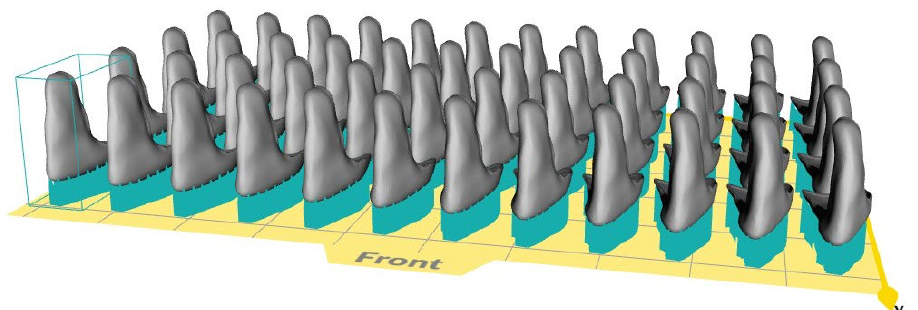
Figure 6. Diastema non-prep veneers on a support structure placed on the virtual build platform of a CeraFab System S65 Medical 3D printer.